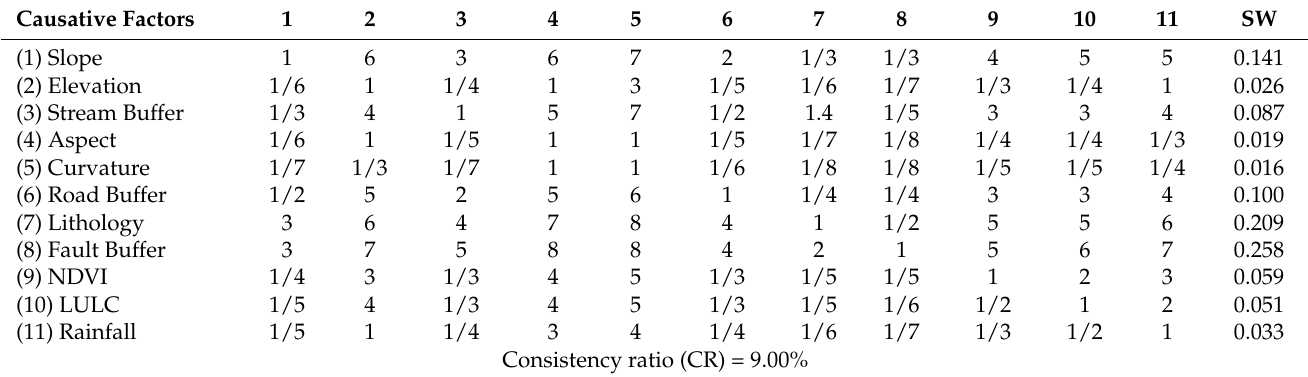
Table 15. Detailed AHP matrices for the SWs of the landslide causative factors.